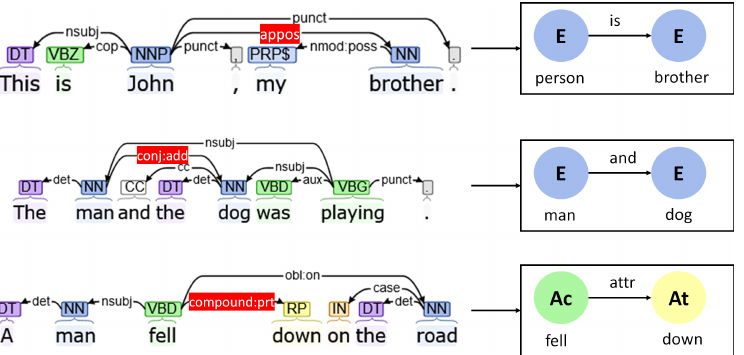
Figure 10. Some more types of dependencies that can represent visual